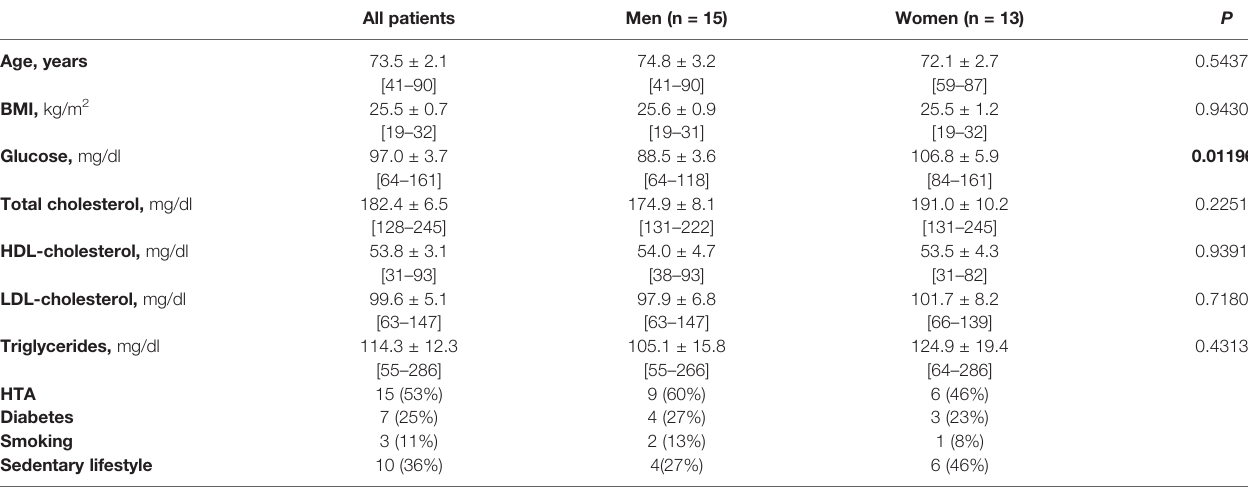
TABLE 1 | Demographical characteristics and biochemical pro fi le of all subjects included in the study, and grouped by gender. All